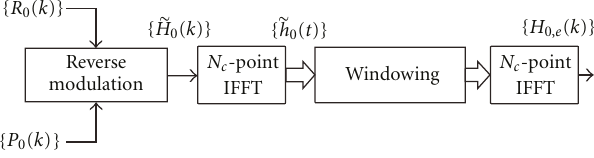
Figure 5: Block diagram for CE with TDM pilot.